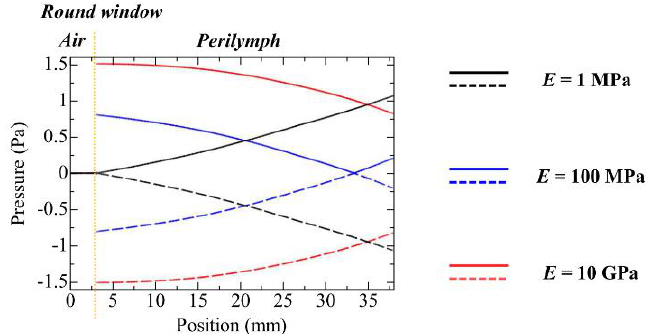
Figure 6. Sound pressure levels evaluated on sound observation line aa’ in Figure 5. Assuming three stages of round window atresia, the Young’s modulus of the round window membrane was set as E = 1 MPa (a healthy ear, in black), E = 100 MPa (an ear with mild round window atresia, in blue), and E = 10 GPa (an ear with severe round window atresia, in red). The position from 0 mm to 3 mm corresponds to the air-filled middle ear region, and the position from 3 mm to 38 mm corresponds to the perilymph-filled scala tympani region. A sinusoidal plane wave with a sound pressure level of 1 Pa and a frequency of 5000 Hz was set for the excitation.